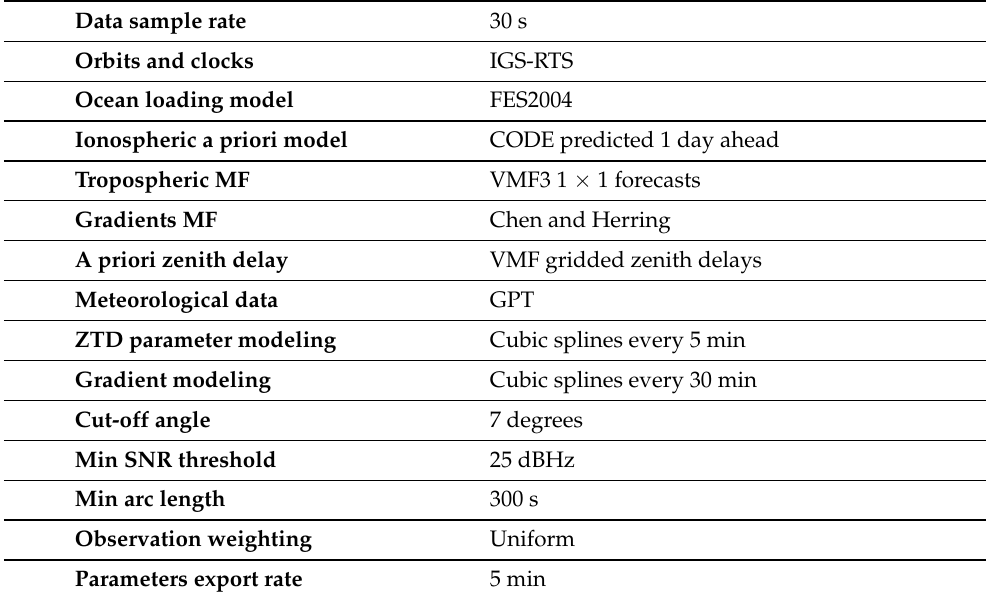
Table 2. Processing parameters used for the GNSS near-real time